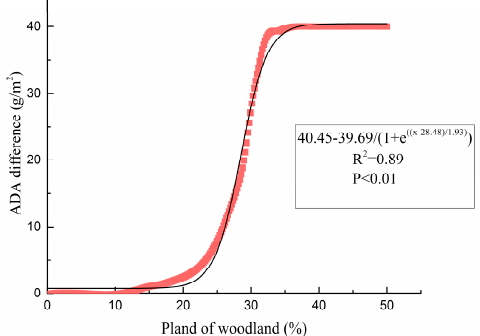
Figure 10. Relationship between the percentage of landscape (PLAND) of woodland and amount of dust absorption (ADA) intensity (g/m 2 ).